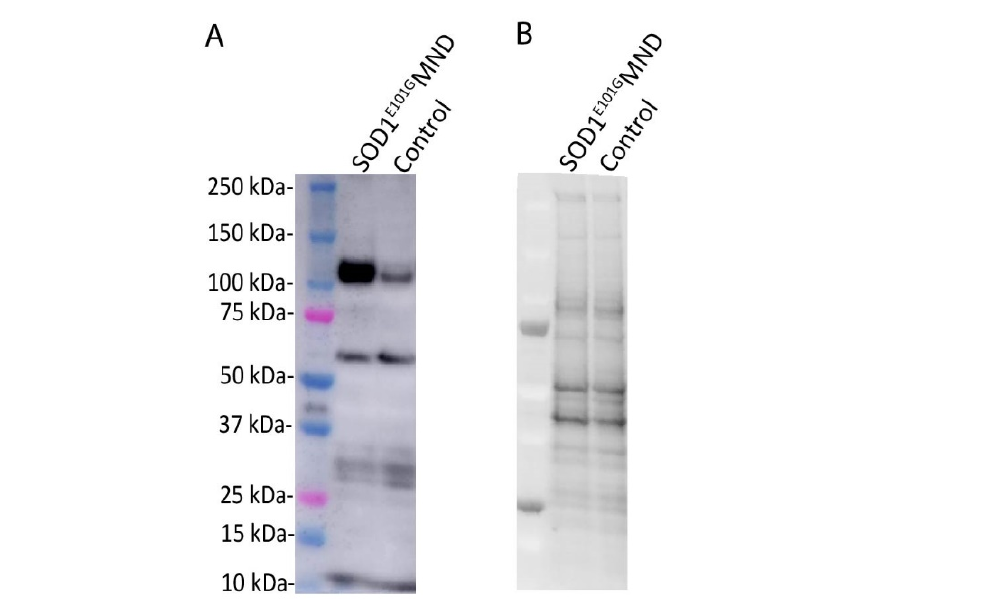
Figure 1. ( A ) Relative levels of EphA4 (110 kDa) are 5× higher in iPSC-derived motor neurons from a SOD1 E101G MND patient compared to iPSC-derived motor neurons from a healthy control. ( B ) Corresponding total protein blot from the SOD1 E101G MND patient and healthy control. Four-week-old iPSC-derived motor neurons were harvested by rinsing in 1 × PBS followed by manual scraping in RIPA buffer (50mM Tris-HCl pH 7.4, 1% NP40, 0.25% Na-deoxycholate, 150 Mm NaCl, 1mM EDTA, phosphate (PhosSTOP, Roche) and protease (complete protease inhibitor cocktail, Roche) inhibitors). Cellular debris was pelleted by means of centrifugation at 10,000 × g for 10 min at 4 ◦ C. The cleared protein lysate was quantified via BCA and 20 µ g of protein was used for Western blotting. Proteins were denatured by boiling at 95 ◦ C for 5 min in Laemmli buffer with 5% β -mercaptoethanol and loaded on a Criterion 4–20% stain-free gel (Biorad). Samples were electrophoresed in SDS-PAGE buffer and transferred onto a PVDF membrane. The membrane was imaged using the Criterion stain-free gel imaging system (Biorad) to obtain total protein values for quantification. The membrane was blocked in 5% skim milk in TBS for 1 h and incubated in EphA4 antibody (1:1000 in 5% skim milk in Tris-buffered saline solution, mouse anti-EphA4, ECM Bioscience) overnight at 4 ◦ C. The membrane was then incubated in an HRP-conjugated secondary antibody and EphA4 (approximate molecular weight 110 kDa) was detected using Pierce ECL Plus Western Blotting substrate (Thermo Fischer) and the chemiluminescence function on the Amersham GE 600 Imager (GE Life Sciences). Densitometry analysis was conducted using Image Studio Lite version 5.2 and each sample measurement was normalised to its corresponding total protein